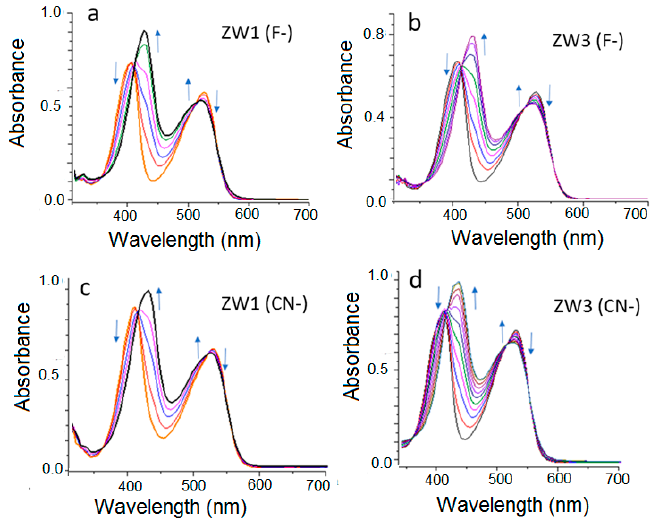
Figure 2. Spectrophotometric titrations (UV/vis absorption spectra) of ZW1 (left, [ ZW1 ] ~ 5 × 10 − 5 M) and ZW3 (right, [ ZW3 ] ~ 7 × 10 − 5 M) in acetonitrile with an acetonitrile solution (10 mM) of ( a , b ) tetraethylammonium fluoride and ( c , d ) tetraethylammonium cyanide. The arrows indicate the evolution of the absorption bands for anion/ZW molar ratios from 0 to 1.